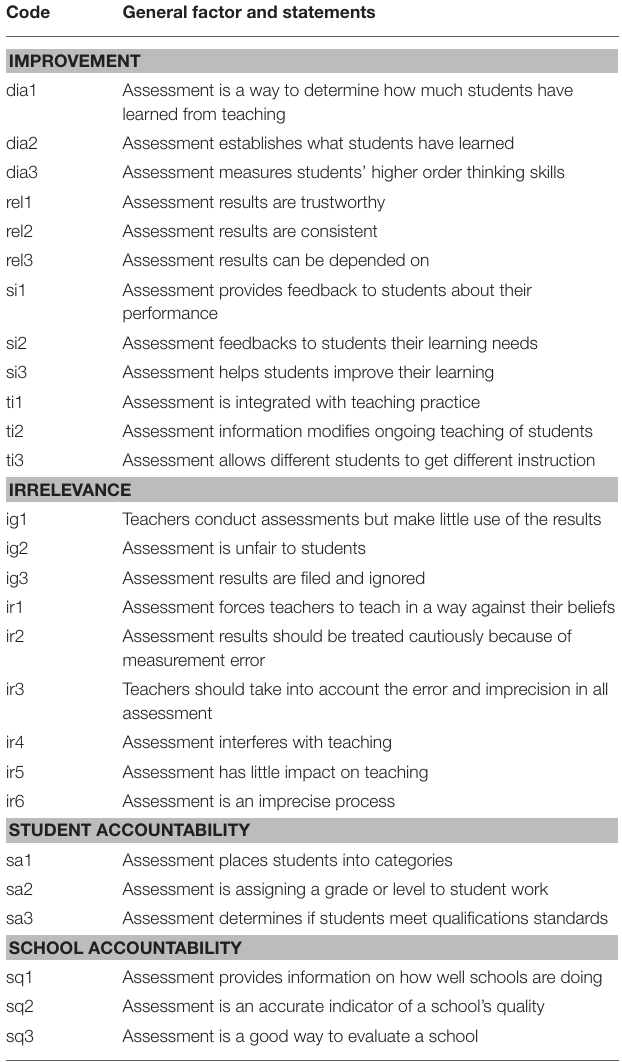
TABLE 2 | TCoA-IIIA items grouped by